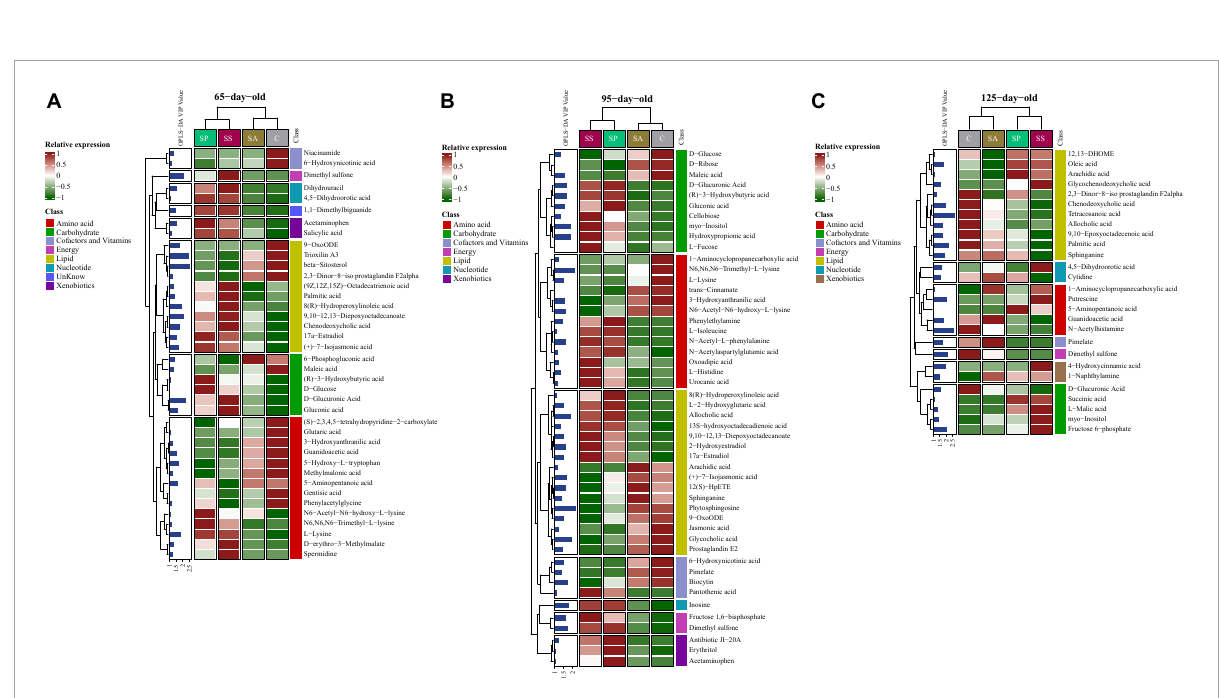
FIGURE6 Analysis of different metabolites in colonic contents of offspring pigs. The heatmap of different metabolites at 65 (A) , 95 (B) , and 125 (C) days of age. 65C, 95C, and 125C, sow fed with basal diet; 65SA, 95SA, and 125SA, sow fed with antibiotic; 65SP, 95SP, and 125SP, sow fed with probiotics; 65SS, 95SS, and 125SS, sow fed with